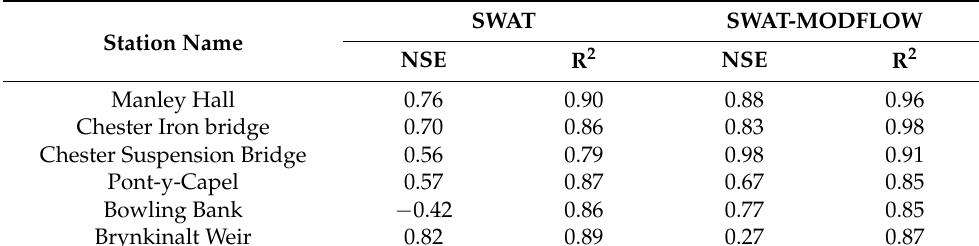
Table 6. Simulated baseflow results of the standalone SWAT model and the coupled SWAT-MODFLOW model for the validation period of 2001–2003.